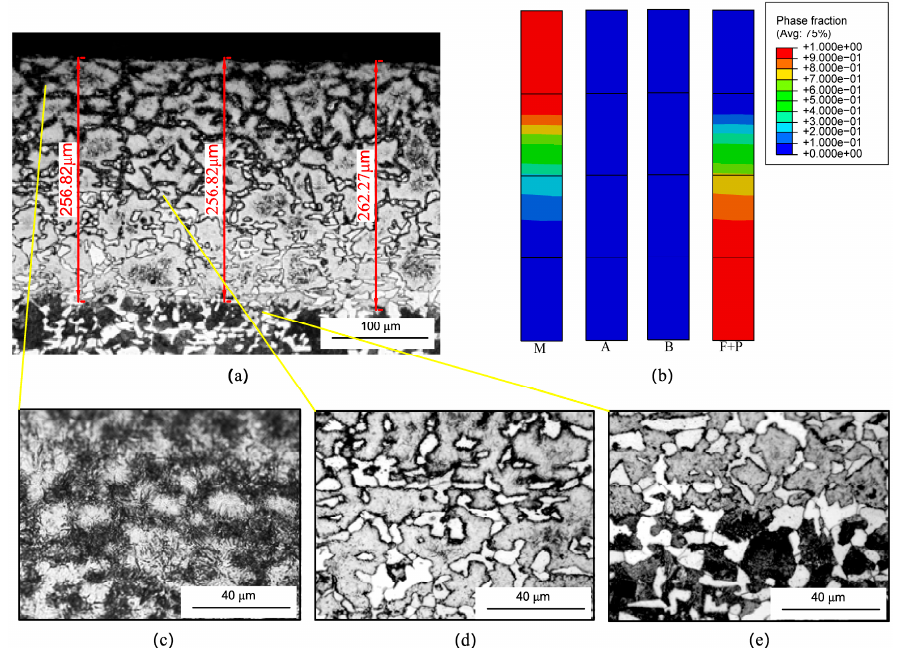
Figure 4. Microstructure distribution of the strengthened layer under no. 1 grinding parameter: ( a ) experimental result; ( b ) simulated result; ( c ) the complete strengthened layer; ( d ) the transition layer; ( e ) the boundary between the strengthened layer and the bulk region.